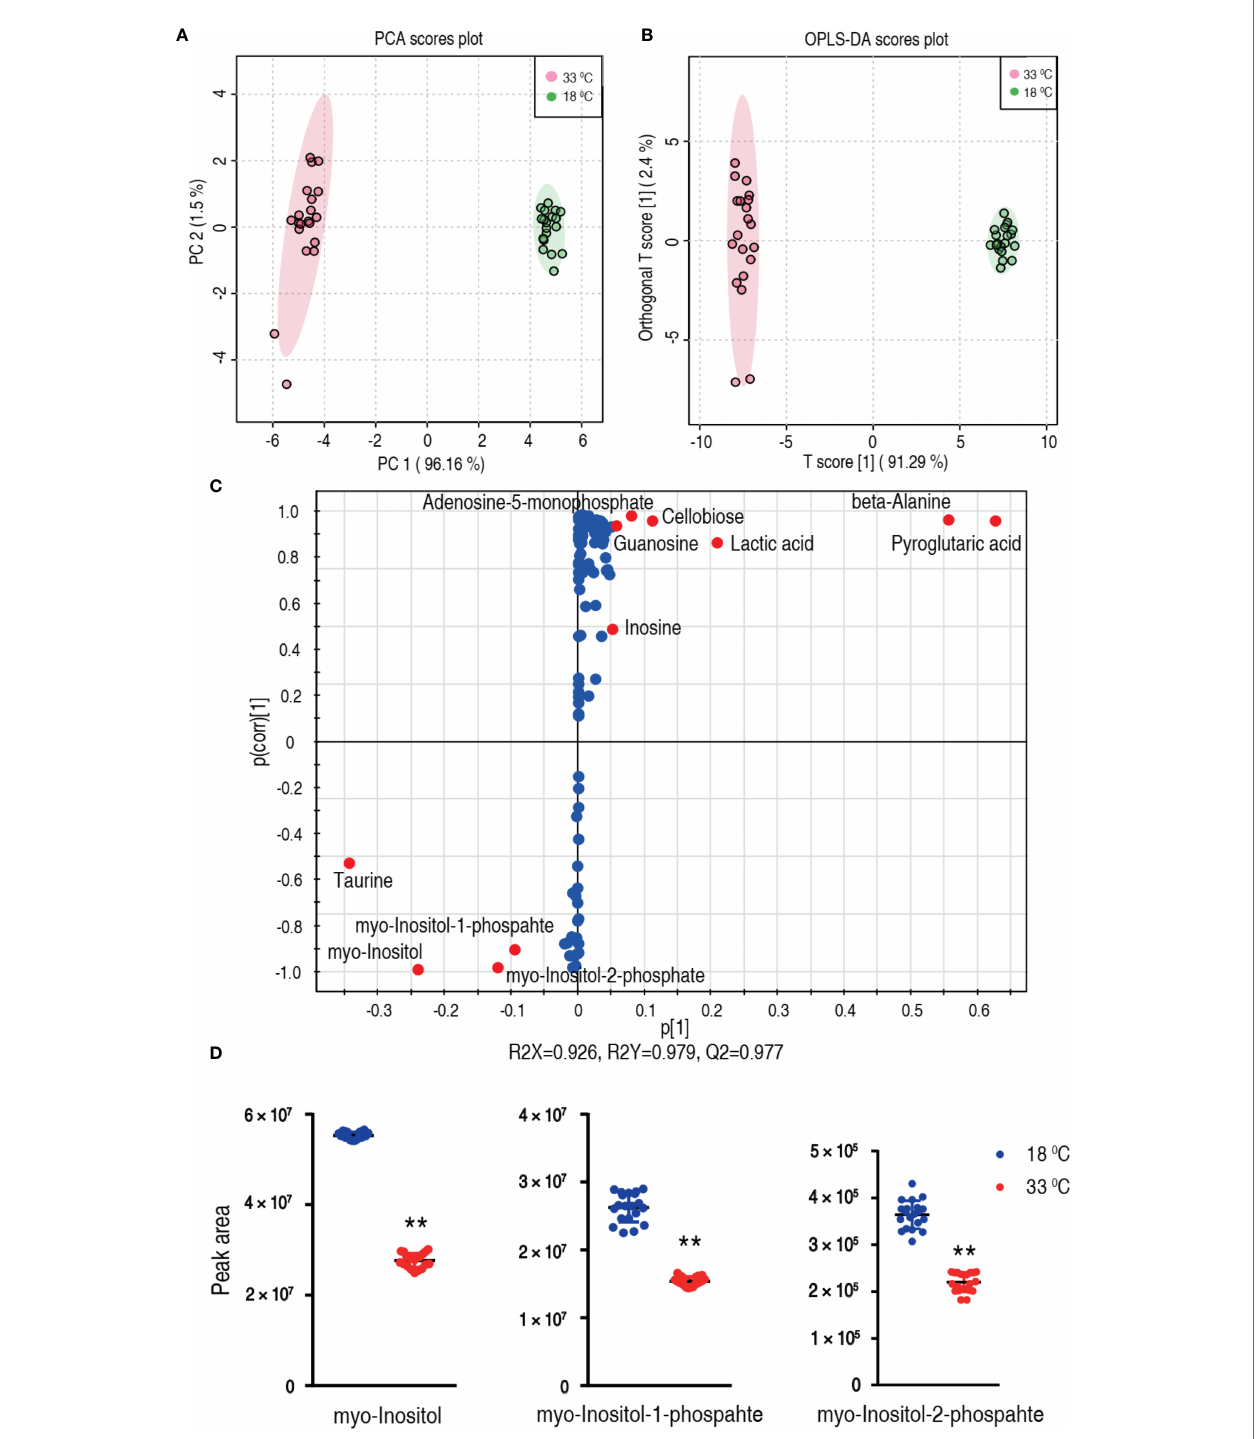
FIGURE 4 | Identi fi cation of crucial metabolites. (A) PCA analysis of 18°C and 33°C groups according to the treatment set. Each dot represents the technological replicate analysis of samples in the plot. PC 1 and PC 2 used in this plot explain 97.66% of the total variance which allows con fi dent interpretation of the variation. (B) OPLS-DA analysis of 18°C and 33°C groups. Dots represent technological replicates. Component 1 (T score [1] = 91.29%) and Component 2 (orthogonal T score [1] = 2.4%) of OPLS-DA explain 93.69% of the total variance. (C) S-plot generates from OPLS-DA (R2X = 0.926, R2Y = 0.979, Q2 = 0.977). Predictive component p[1] and correlation p(corr)[1] differentiate 18°C from 33°C. Dot represents metabolites, and candidate biomarkers are highlighted in red. (D) Scatter plot of myo -inositol, myo-inositol-1-phosphate, and myo-inositol-2-phosphate. **p <